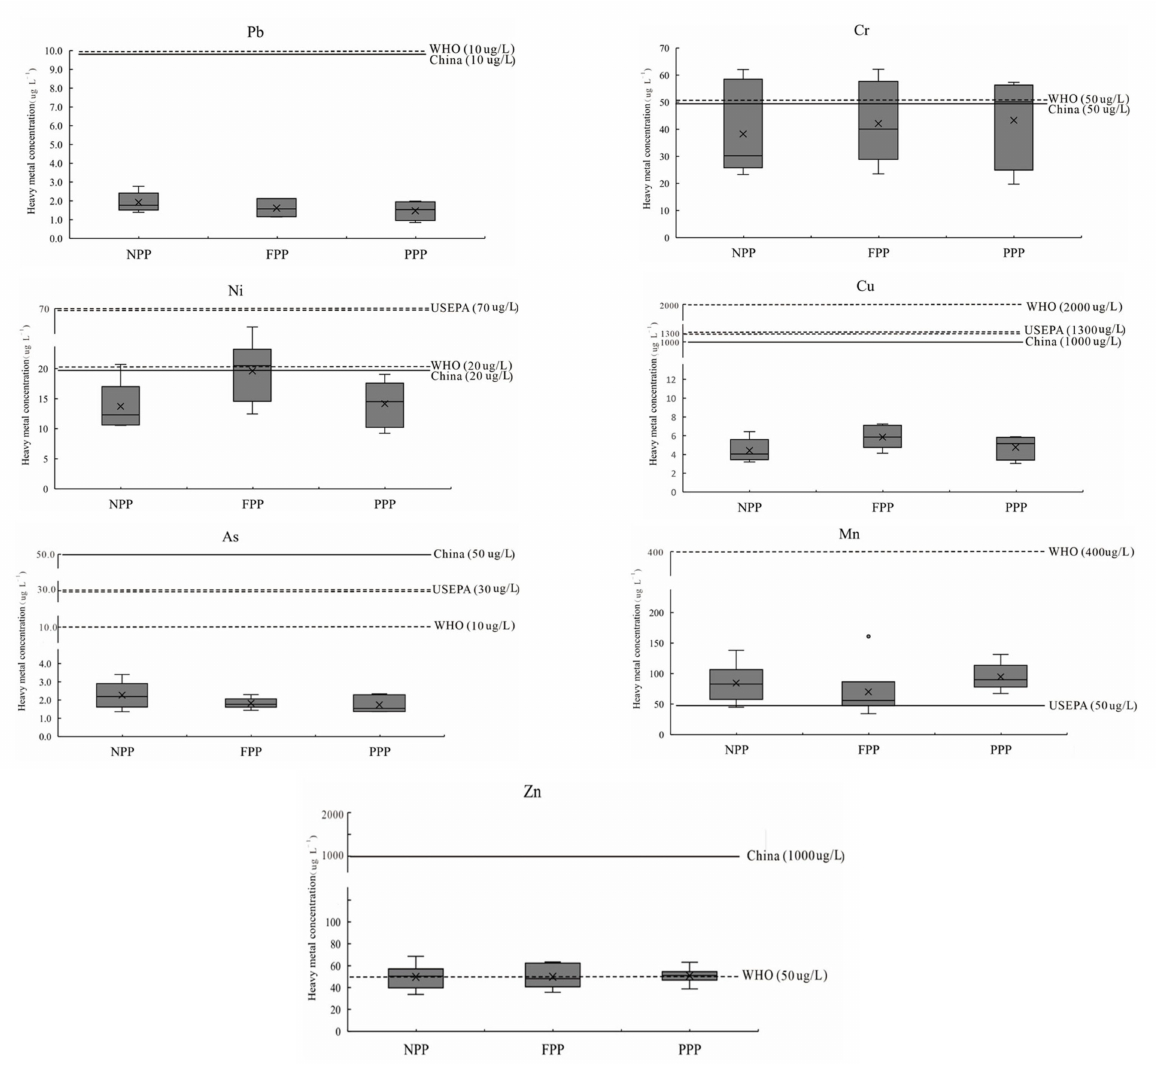
Figure 3. Heavy metals concentration variation in different subsidence